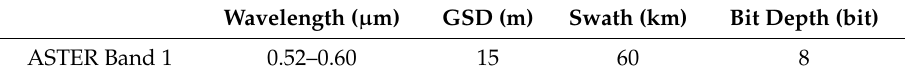
Table 1. Specifications of ASTER Band 1 onboard Terra.